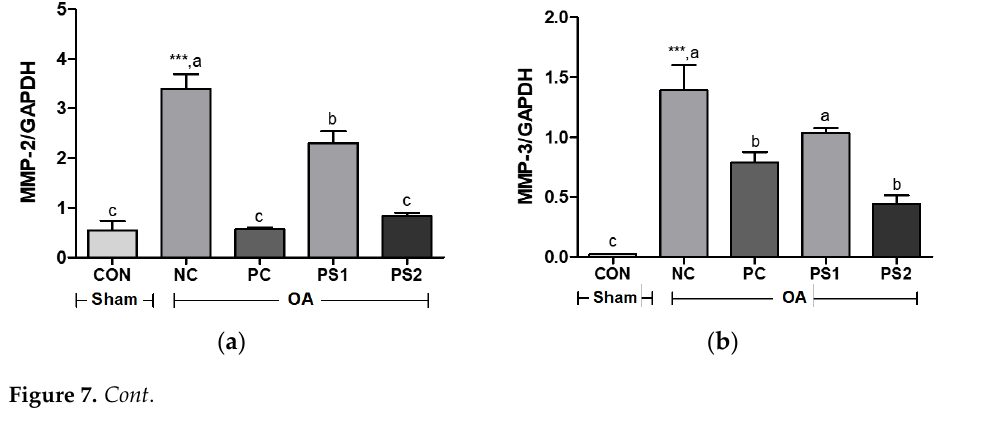
Figure 6. Effects of PS on cytokines expression in the cartilage with synovial membrane of OA rats. ( a ) IL-6 and ( b ) IL-18. Data are expressed as the mean ± SE (n = 4/group). CON: normal sham control; NC: negative control; PC: positive control; PS1: PS at 100 mg/kg BW; PS2: PS at 300 mg/kg BW. NC group was significantly different from the CON group at *** p < 0.001 by Student’s t test. a – c Mean values with different letters are significantly different ( p < 0.05) among groups by Duncan’s multiple range test.